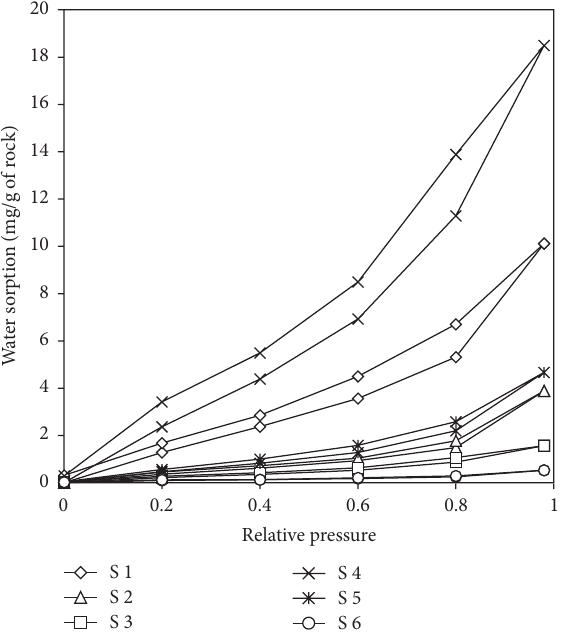
Figure 5: Sorption/desorption isotherms of sandstones expressed by mg of water adsorbed per 1g of